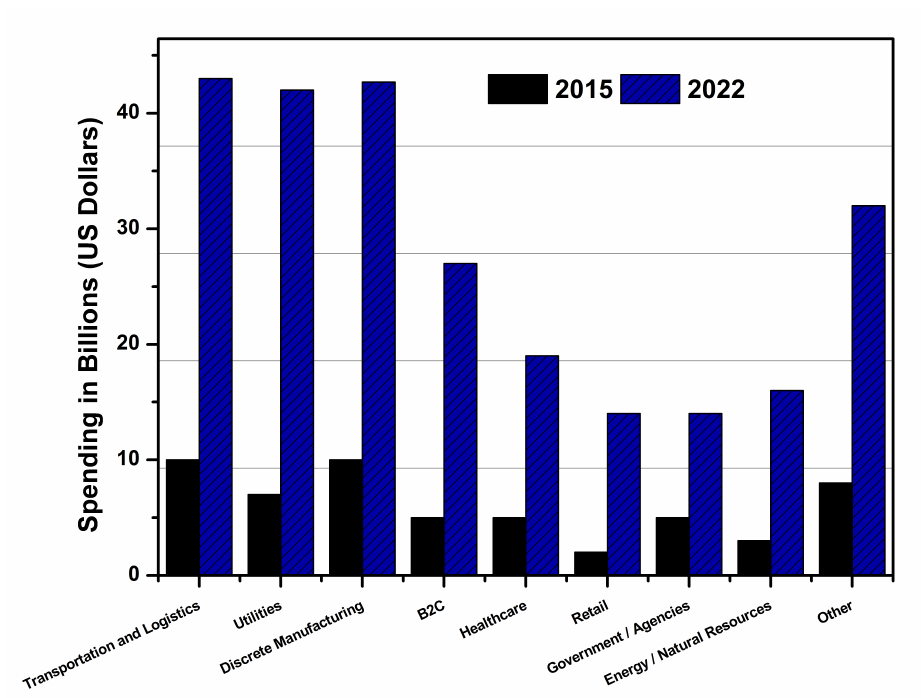
Figure 2. Market spending projection (USD billion) in various IoT industry sectors.